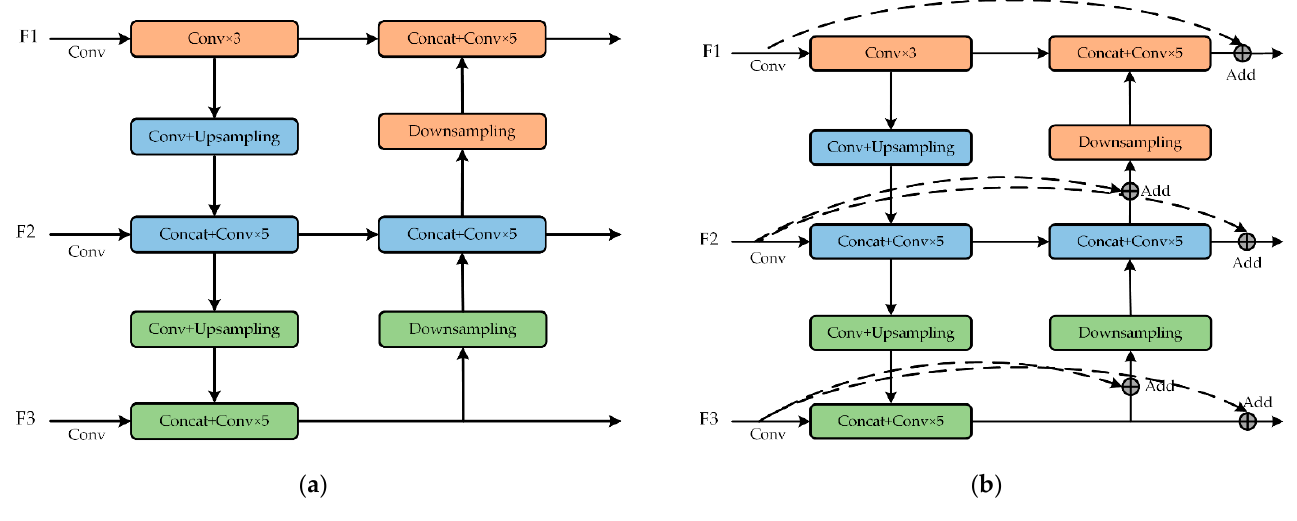
Figure 5. The network structure of PANet and BiPANet. Conv denotes convolution. ( a ) PANet and ( b ) BiPANet. Up-sampling represents reducing the scales of the feature maps to twice their original scales. In contrast to up-sampling, down-sampling represents enlarging the scales of the feature maps to twice the original scales. Add means that the values in two feature maps are summed.